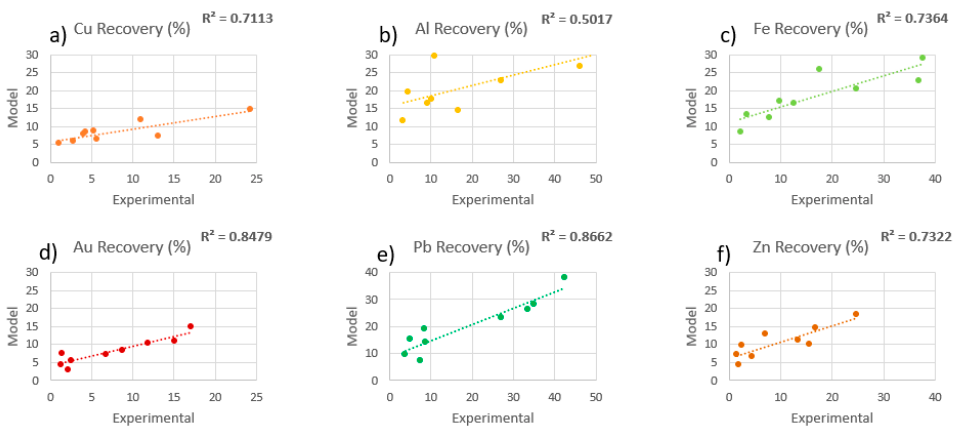
Figure 13. Correlation between the experimentally determined and calculated metal recovery using the model equations after hammer milling for product size fraction 1–2 mm. ( a ) Cu, ( b ) Al ( c ) Fe, ( d ) Au, ( e ) Pb, and ( f ) Zn. Feed particle size fraction was 1–2 mm.